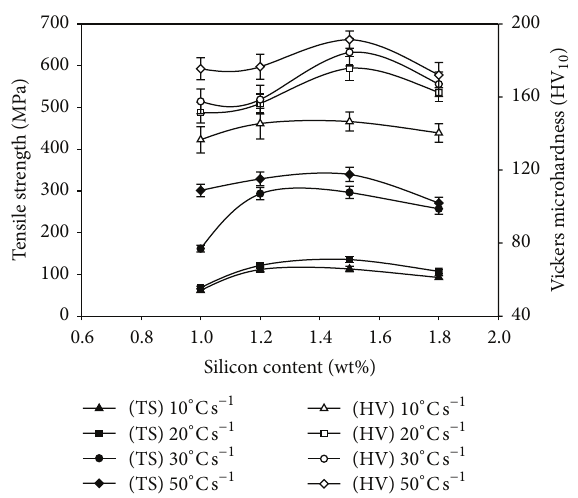
Figure 10: Effect of Si content on the microhardness and tensile strength of Al-Zn alloys with different cooling